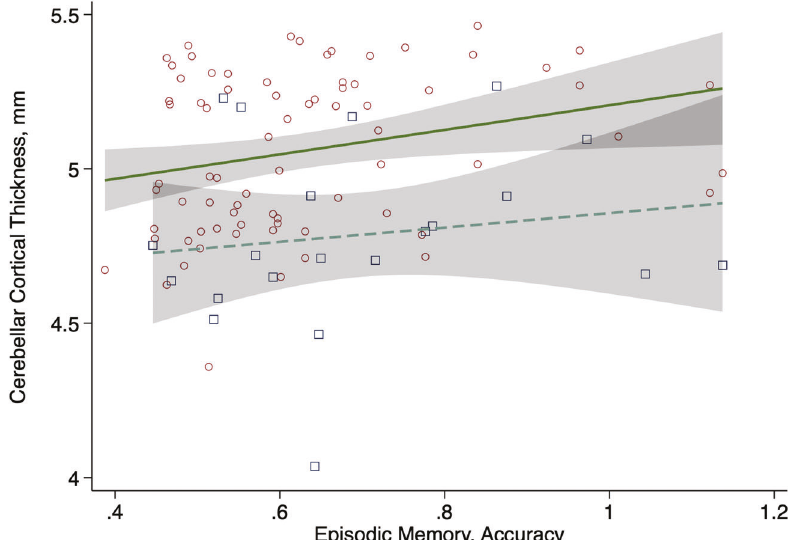
Fig. 3 Association between cerebellar cortical thickness (mm) and episodic memory (coef fi cient = 0.35, standard error = 0.15, p -value = 0.021) adjusted for gender. Males: small red circles and solid green line; females: large blue squares and dashed line; 95% con fi dence intervals shown using transparent gray from both the right and left hemispheres, predominantly in the right hemisphere (Table 2). Following adjustment for the false discovery rate, cortical thickness was associated with subregional reductions in the right (Crus I and II, and lobule VIIIa) and left (Crus II and in lobules VI, VIIb, VIIIa, and X) hemisphere. Associations were also evident with cognitive performance, particularly episodic memory both with and without adjusting for sex (e.g., Fig. 3). Note that results were not signi fi cantly different between males and females, but the number of females in the sample does not allow for reliable subgroup analysis, showing only overall results. Results showed signi fi cant associations